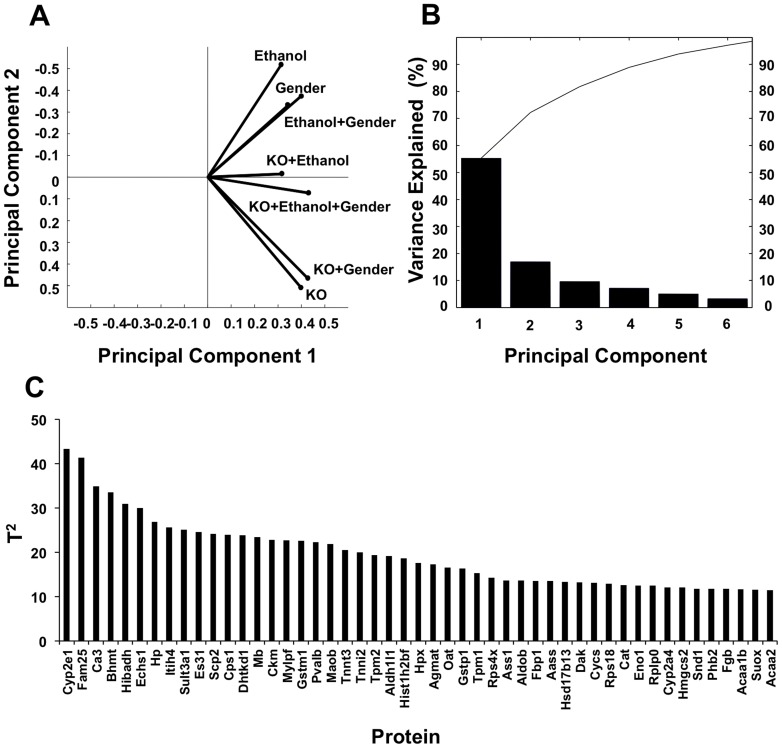
Principal component analysis of the proteomic results.(A) Biplots of PCA of seven observations which predicted to the space defined by the first and second principle components. (B) Variance explained by the top six principle components in seven observations. Each bar represents the individual variance explained by the principle component, and the curve shows cumulative explained variance of top principle components. (C) Proteins having Hotelling's T2 values greater than the third quartile.